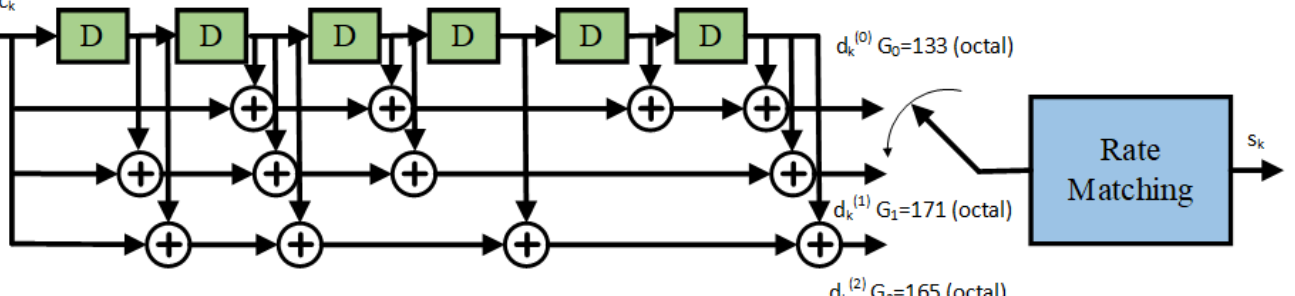
Figure 2. Overview of a rate 1/3 tail-biting convolutional coding with rate matching for NB-IoT